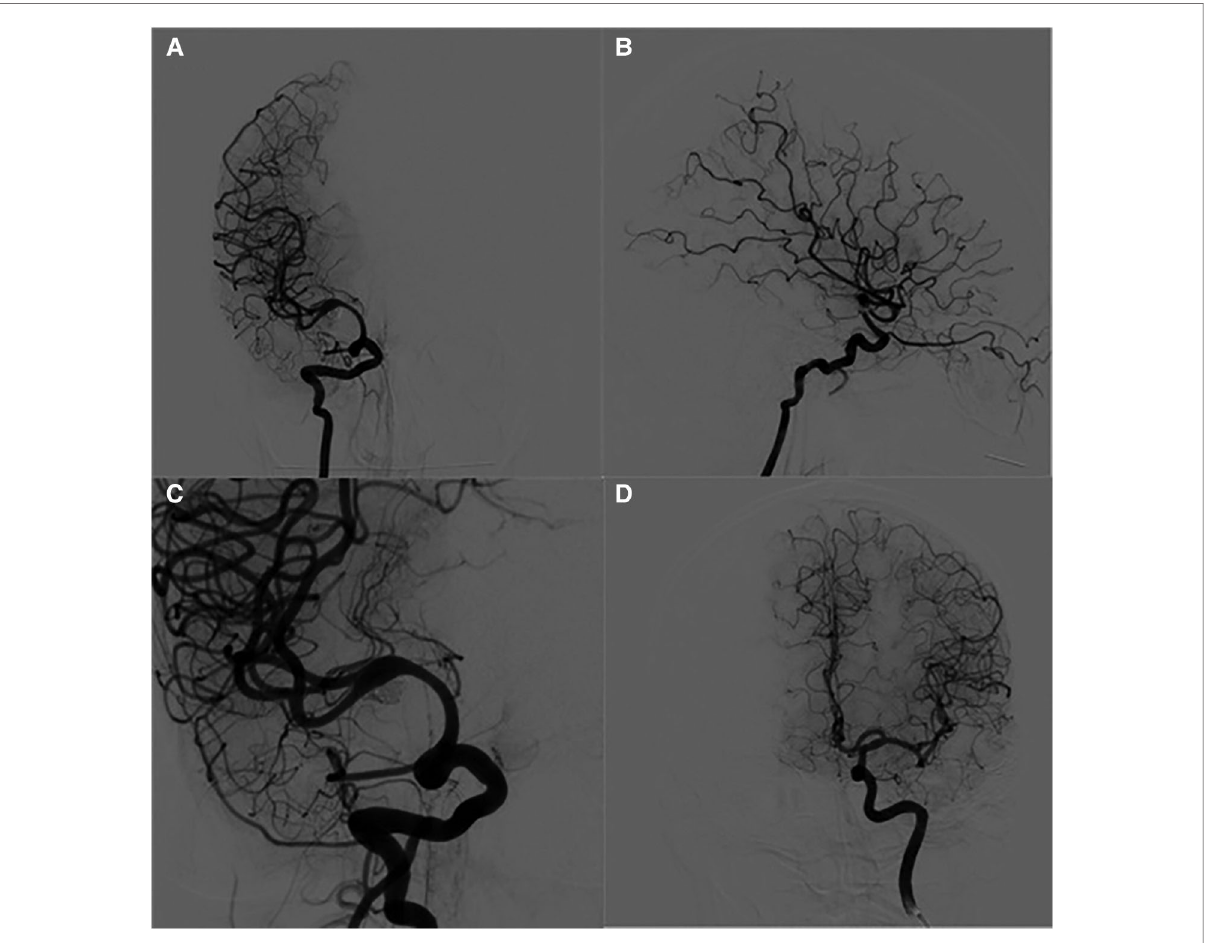
FIGURE 3 DSA images fi ndings 12-months after operation. ( A ) anteroposterior angiography of the right internal carotid artery. ( B ) Lateral angiography of the right internal carotid artery. ( C ) The working position angiography showed that the stenosis at the distal and proximal ends of the stent disappeared. ( D ) The anteroposterior angiography of the left internal carotid artery showed that the anterior communicating artery was open and the ipsilateral anterior cerebral artery was well